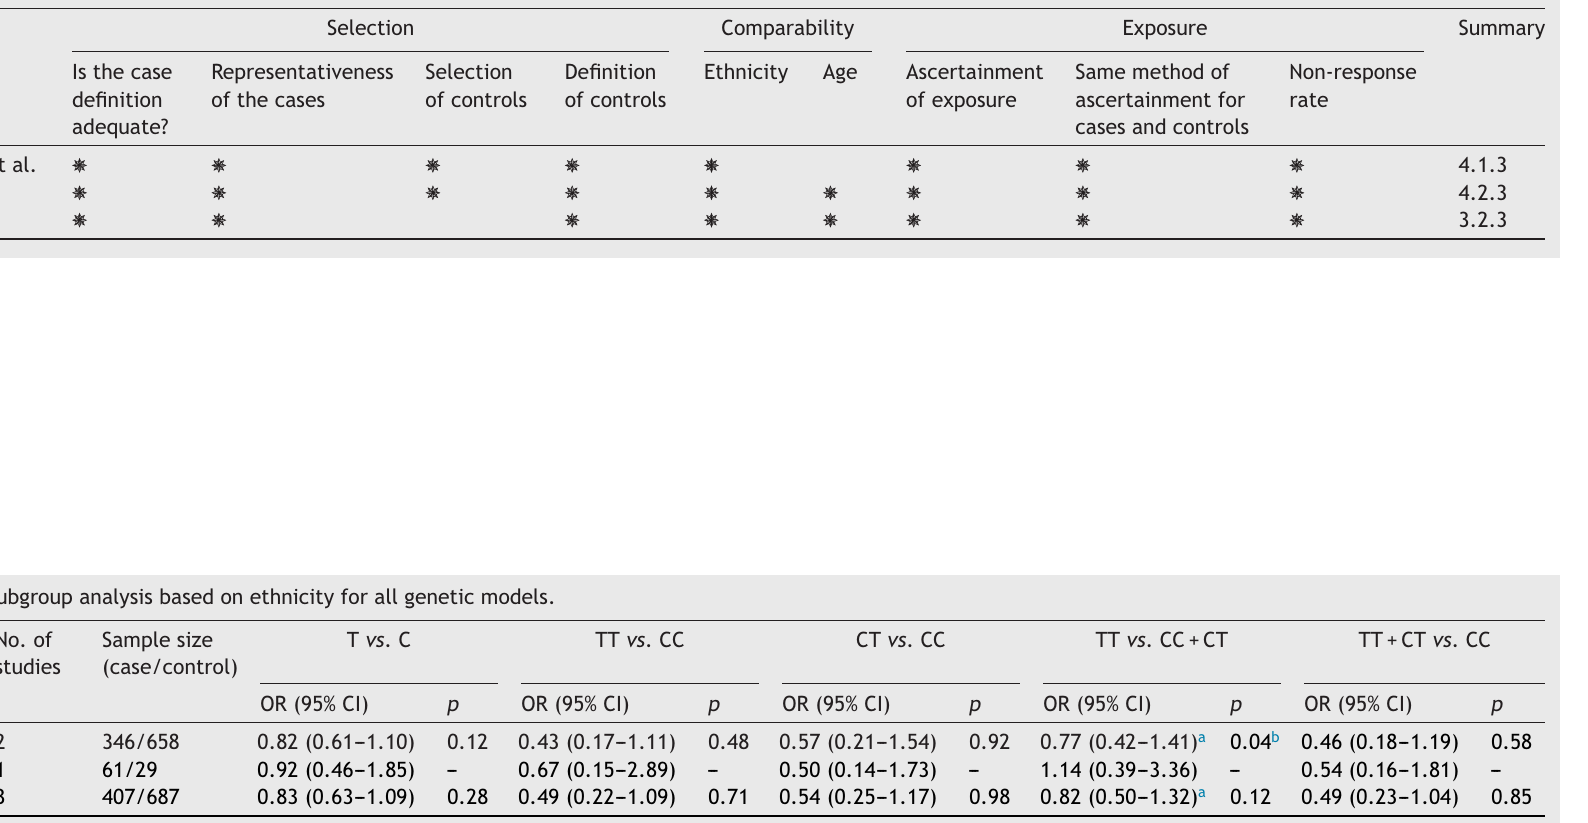
Quality assessment of included studies.